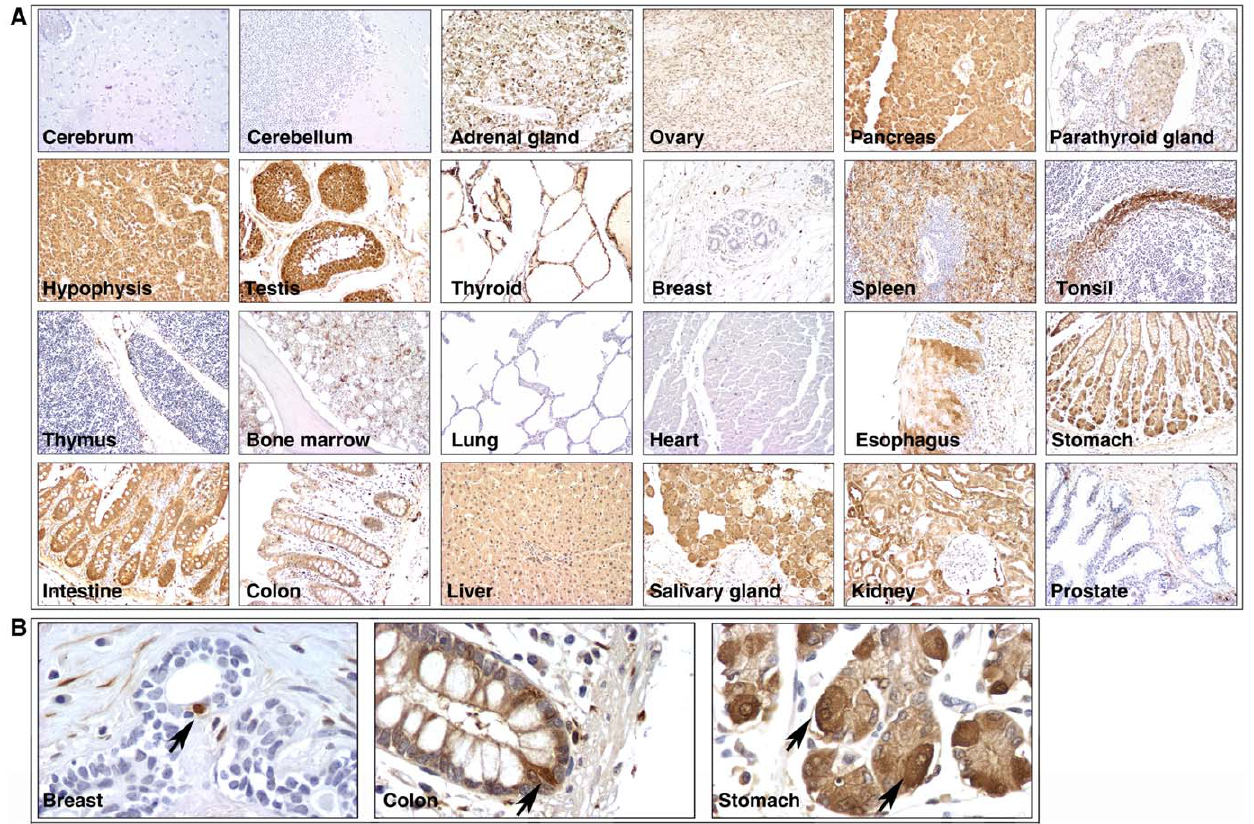
Figure 1. Expression and distribution of ALDH1 protein in normal human tissues. A . An FDA normal human organ tissue microarray was used to characterize the expression and distribution of ALDH1 in 24 tissues. B . Strongly positive ALDH1 cells were found in the areas in which epithelial stem/progenitor cells were putatively located in breast, colon and stomach.